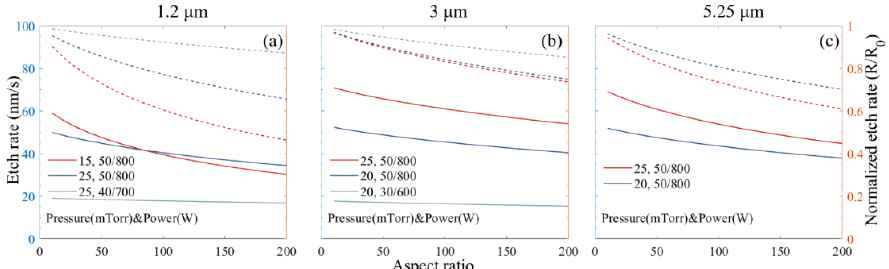
Figure 5. Solid lines: etch rate ( R ) as a function of aspect ratio ( α ) fitted with Equations (3)–(6); dotted lines: normalized etch rate ( R / R 0 ) for different grating periods: ( a ) 1.2 μm; ( b ) 3 μm; ( c ) 5.25 μm.